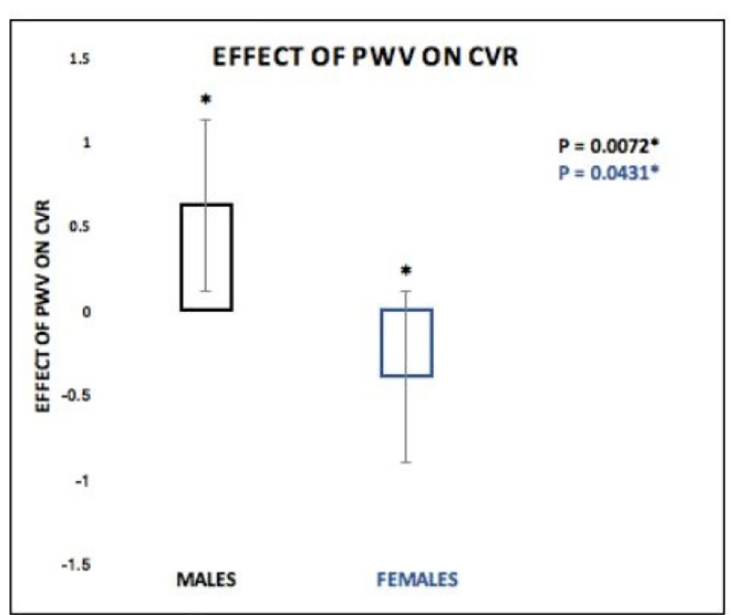
Fig 2. Effect of PWV on CVR. CVR was significantly positive in males (p = 0.0072 � ) and significantly negative in females (p = 0.0431).